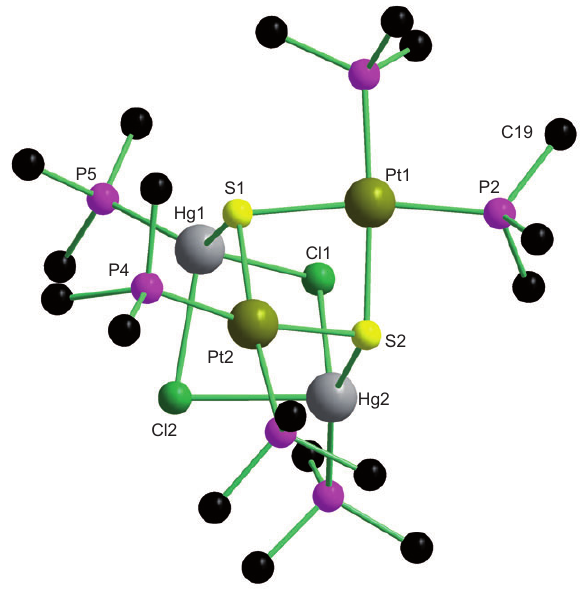
Figure 4 Structure of [(PPh Phenyl groups were omitted for clarity. Modified from Li et al.